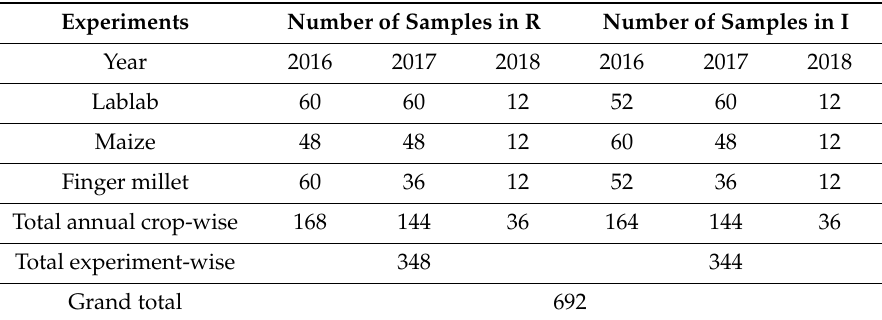
Table 2. Total number of samples from rainfed (R) and irrigated (I)